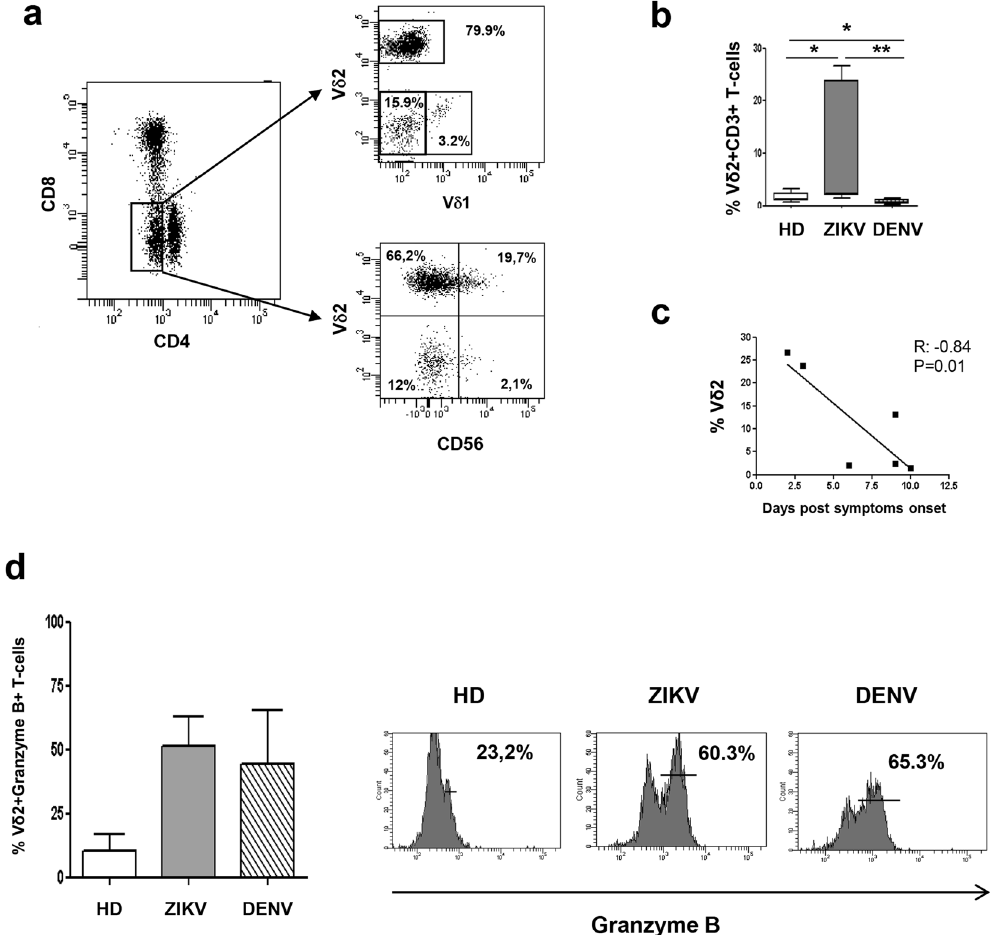
Figure 4. The expanded DN T-cells express V δ 2 TCR. Flow cytometric panels showing the expression of V δ 1- TCR, V δ 2 TCR and CD56 marker on DN T-cells are shown ( a ). The frequency of V δ 2 within CD3 T-cells ( b ) was compared in HD (white bars), ZIKV (grey bars) and in DENV (hatched bars). The correlation between time after sympthoms onset (days) and the V δ 2 T cell frequency ( c ) during Zika infection is shown. The frequency of granzyme positive V δ 2 T cells ( d ) was compared in HD (white bars), ZIKV (grey bars) and in DENV (hatched bars). * p <